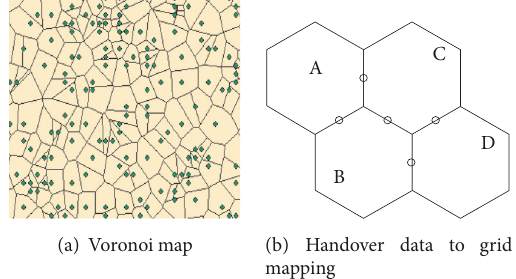
Figure 3: Grid mapping of cellular probe event.